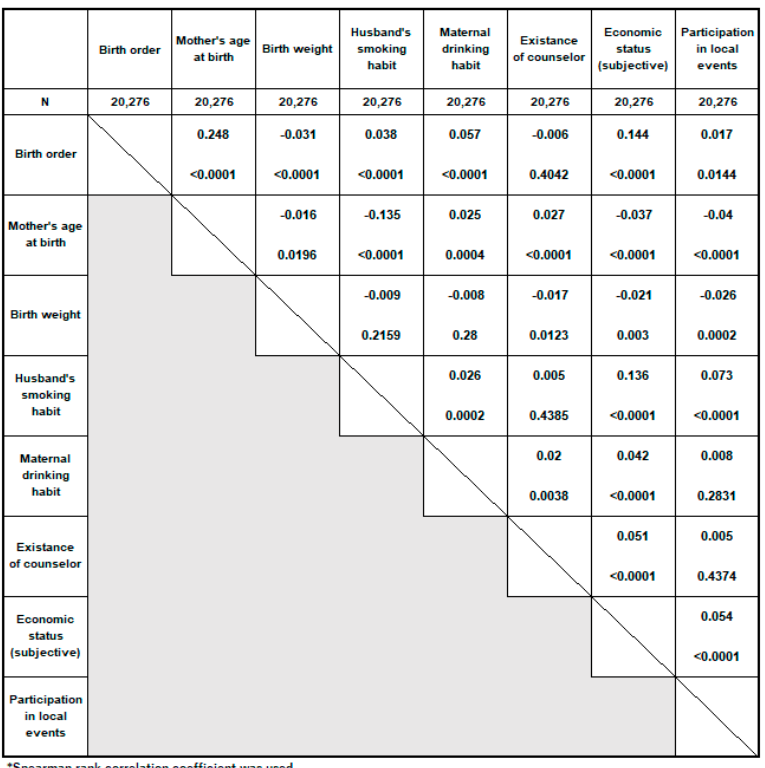
ffi cient of correlation between individual Figure A1. Coefficient of correlation between individual variables. 128 Figure A1. Coe